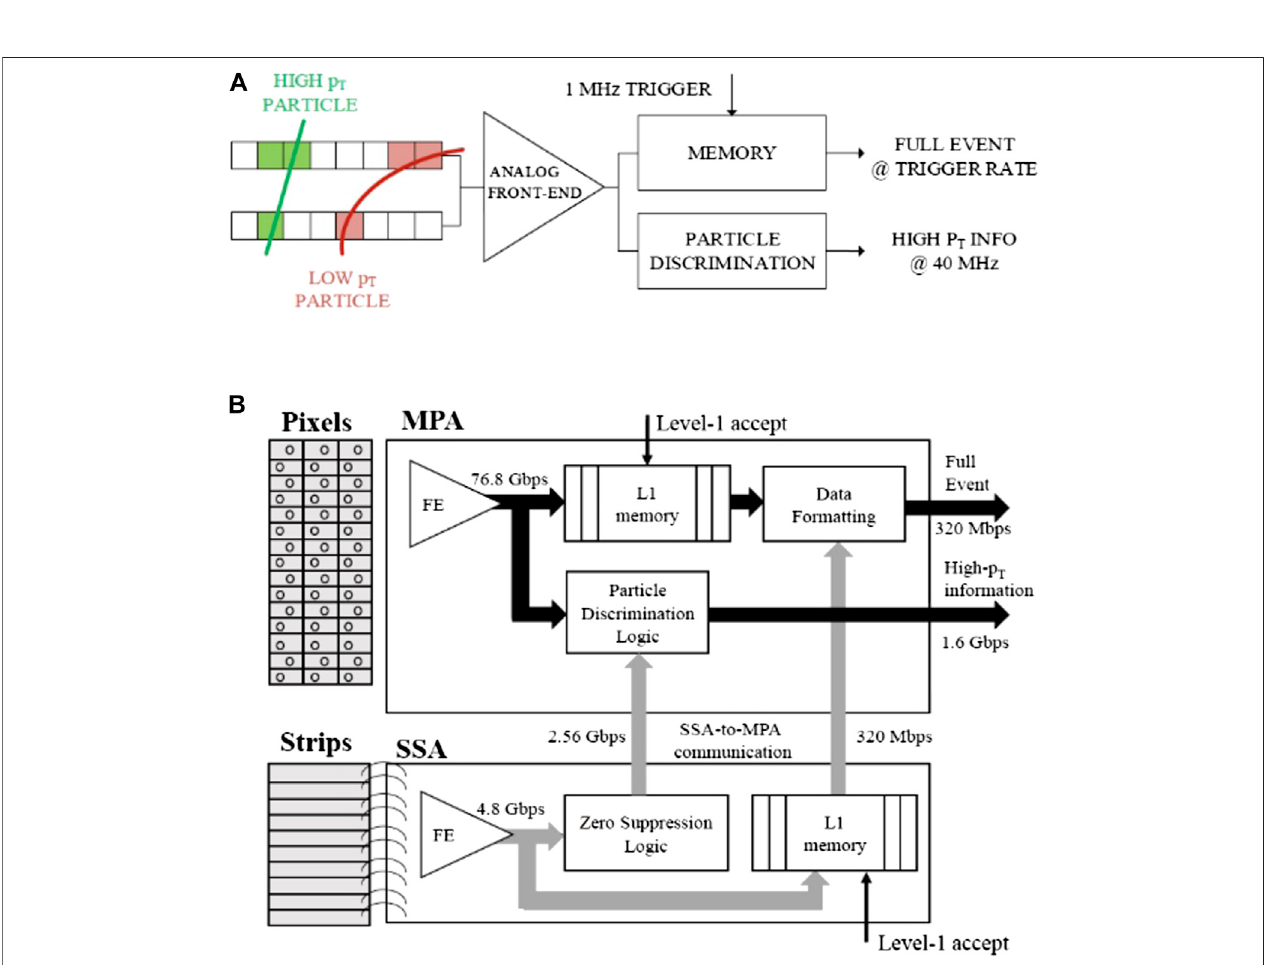
Frontiers in Physics |